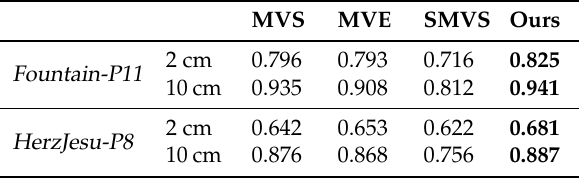
Table 2. Ratio of pixels with absolute errors less than 2 cm and 10 cm on Fountain-P11 and Herz-Jesu-P8 .